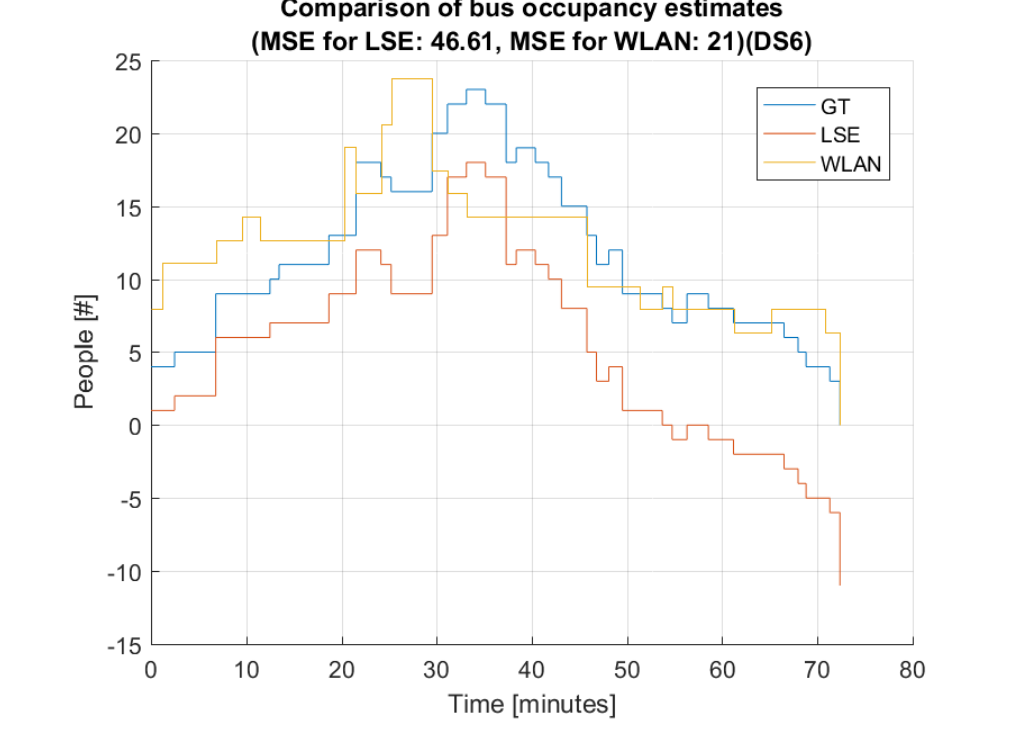
Figure 9. Comparison of LSE and WLAN with GT based on data set 6 (DS6).